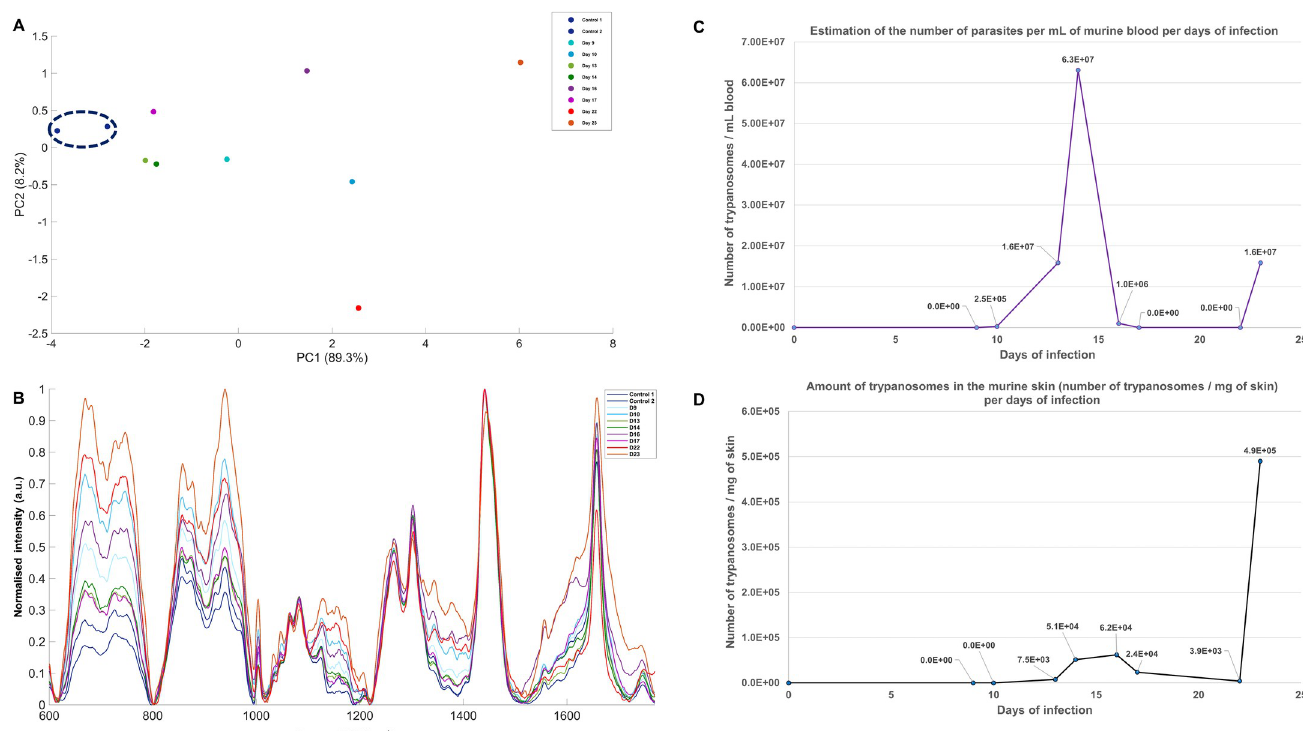
Fig 5. In Situ Raman analysis of a T . b . brucei infection time course in C57/black6J mice compared to detectable blood parasitaemia and skin parasite burden. (A) PCA scores plot, (B) spectral comparison of each averaged and normalised Raman spectrum, (C) estimation of the blood parasitaemia and (D) estimated number of parasites/ mg skin by qPCR for PFR2 gene over the same time course as the Raman measurements. Raman measurements were obtained using a 785 nm excitation laser with a 30 s acquisition time and five measurements were taken across each skin sample.